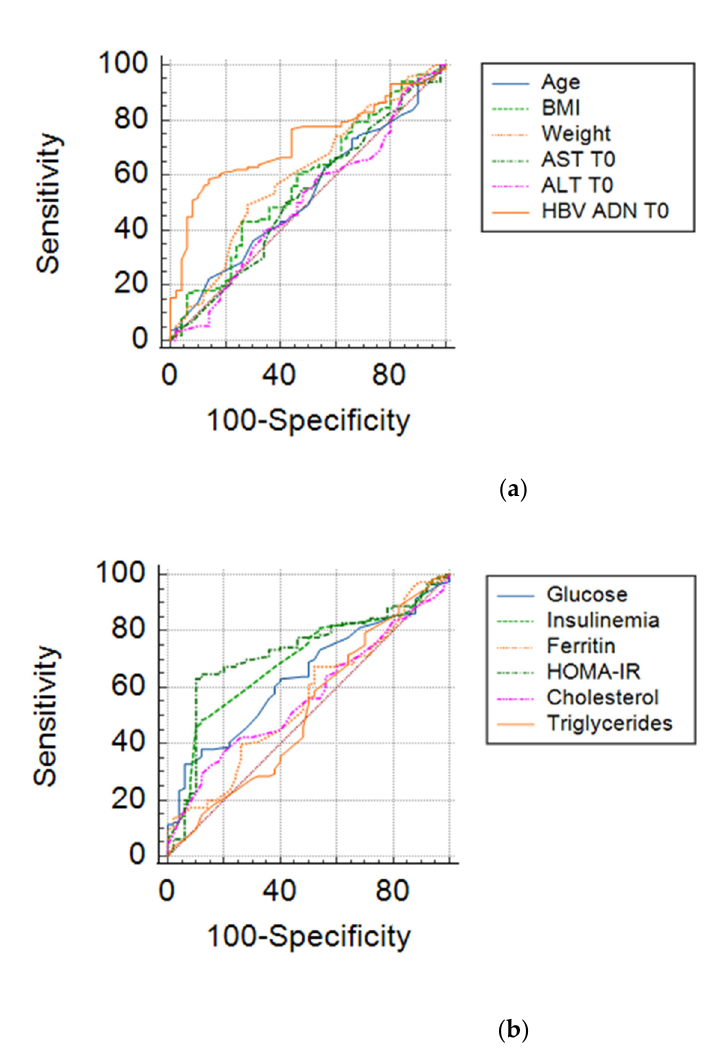
Figure 5. ROC curves for clinical-biochemical parameters: ( a ) Age, Weight, BMI, ALT T0, AST T0, HBV-DNA; ( b ) Glucose, Insulinemia, Ferritin, HOMA-IR, Cholesterol, Triglycerides.